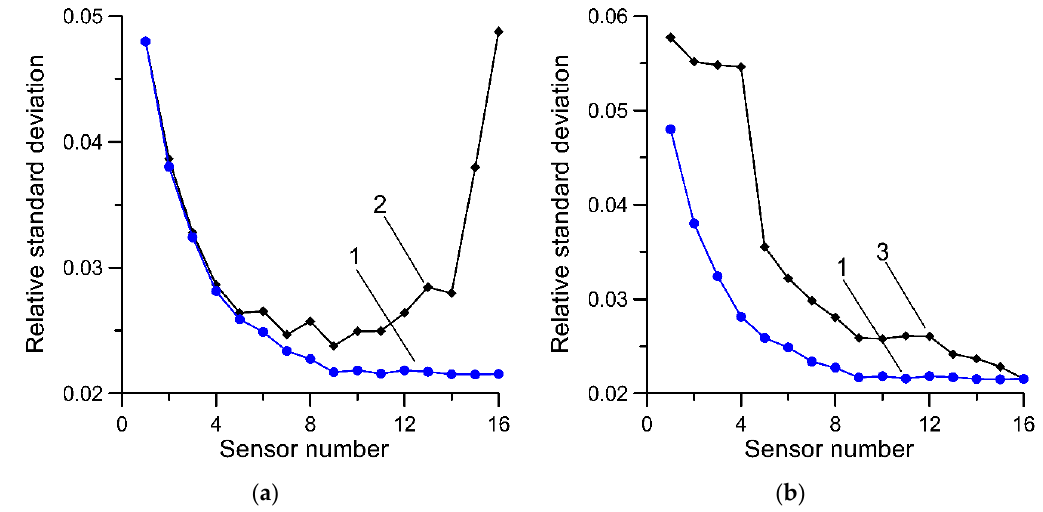
Figure 2. Dependency of relative standard deviation as a function of the number of load sensors for Equation (7). ( a ) 1—the uncertainty of Equation (7) when the load sensors were averaged in order of increasing uncertainty, 2—as a comparison for Equation (1); ( b ) 1—the uncertainty of Equation (7) when the load sensors were averaged in order of increasing uncertainty, 3—the uncertainty of Equation (7) when sensors were arranged in the order in which they are installed at the MS-WIM